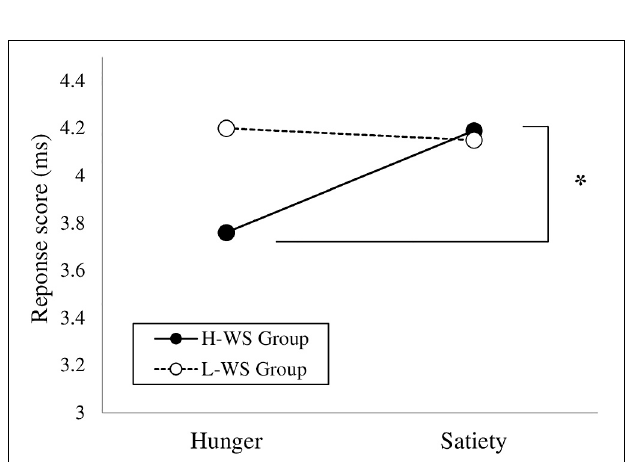
FIGURE 2 | Explicit Approach and Avoidance of the High and Low Levels of Weight Suppression Groups ( *p < 0.05, ** p < 0.01). H-WS Group, High Weight Suppression Group; L-WS Group, Low Weight Suppression Group.